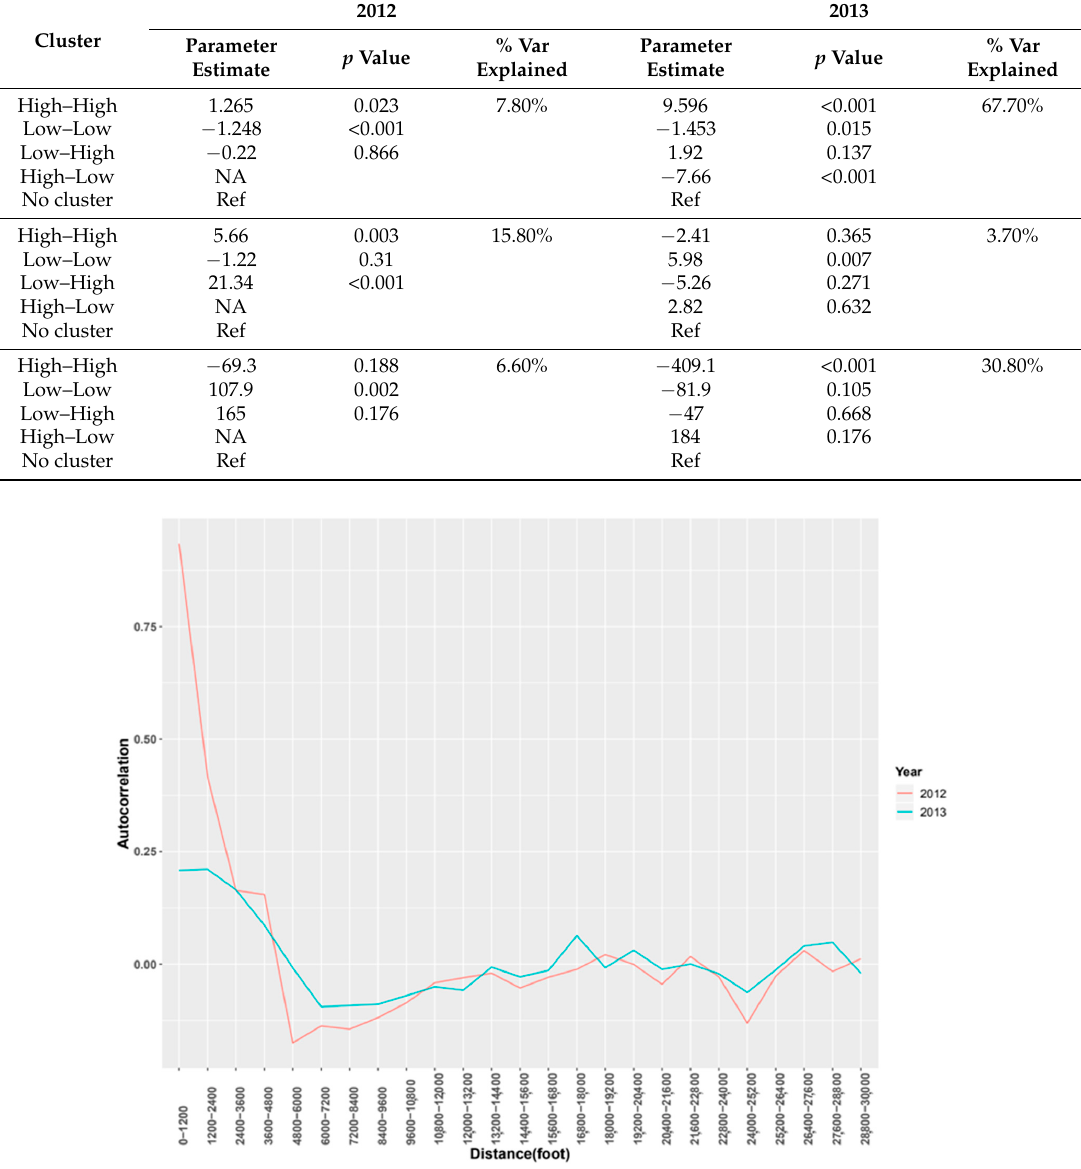
Figure A3. Spatial autocorrelation of dengue incidence rates as a function of distance.